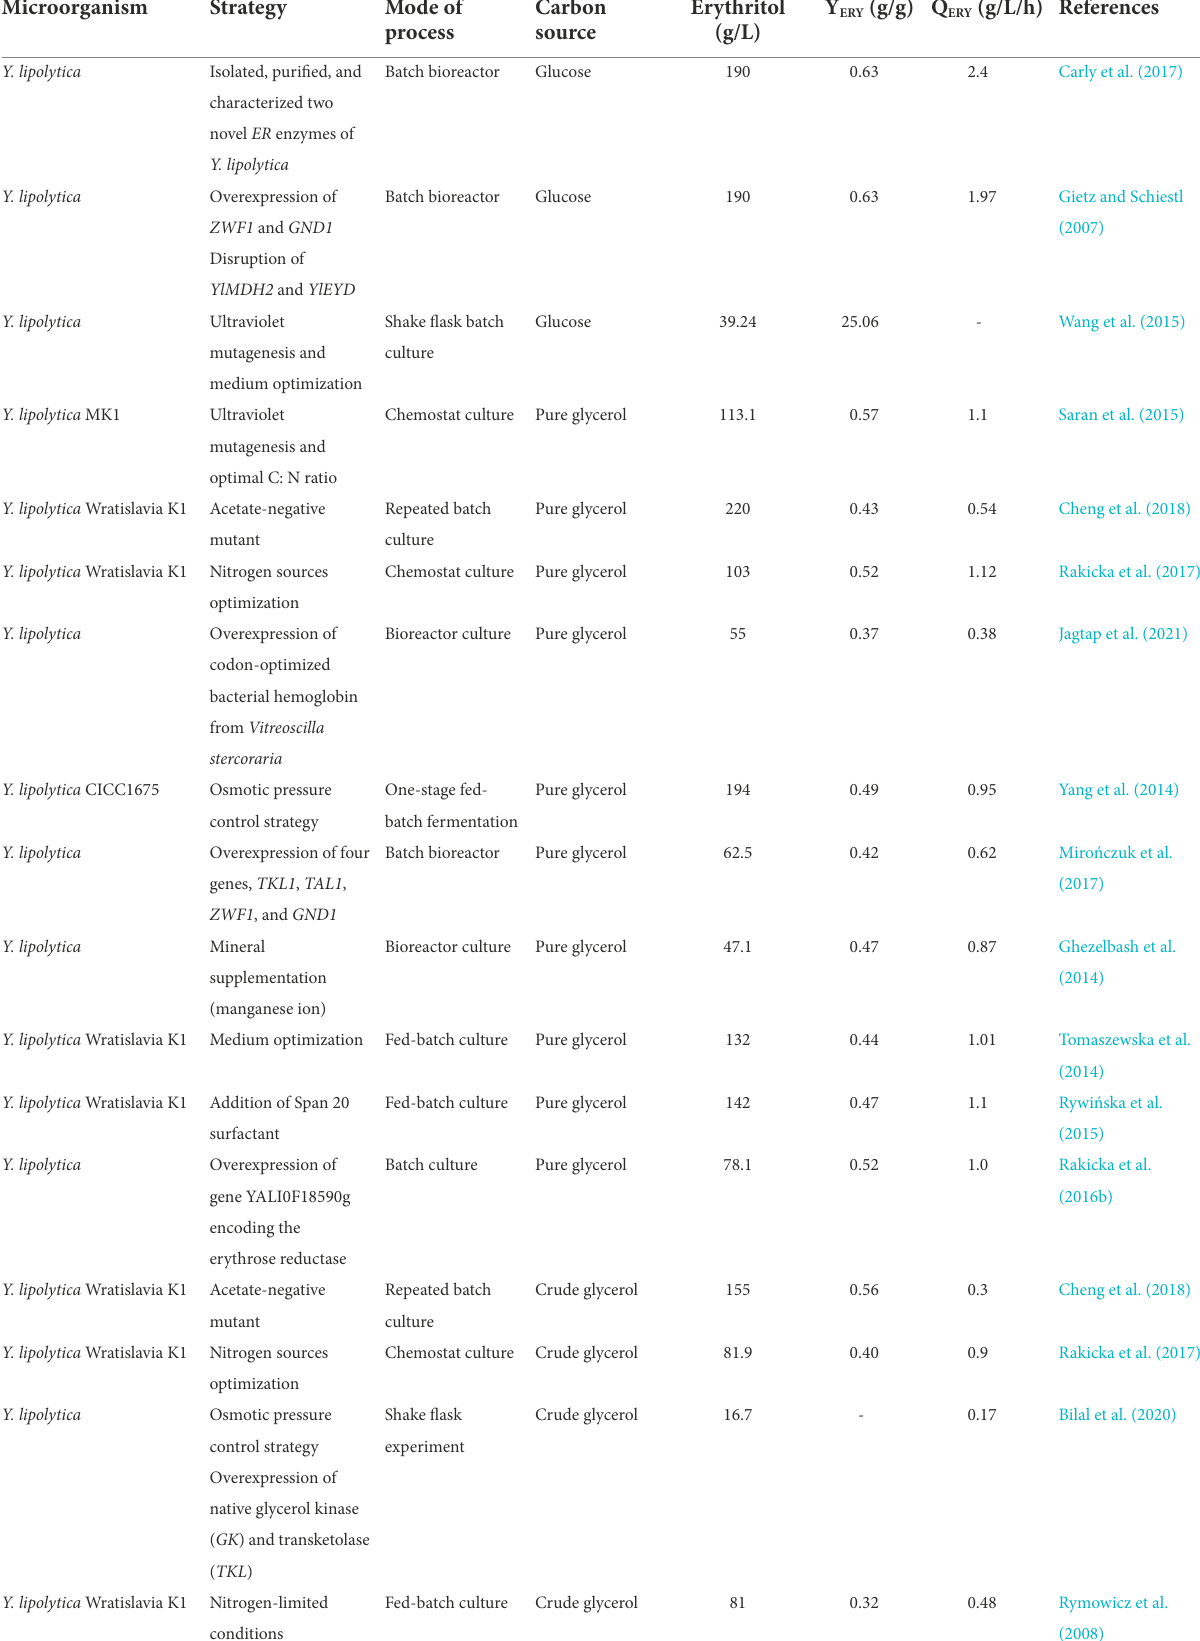
TABLE 1 Comparison of erythritol titers, yields, and productivities in various Yarrowia lipolytica strains. Microorganism Strategy Mode of